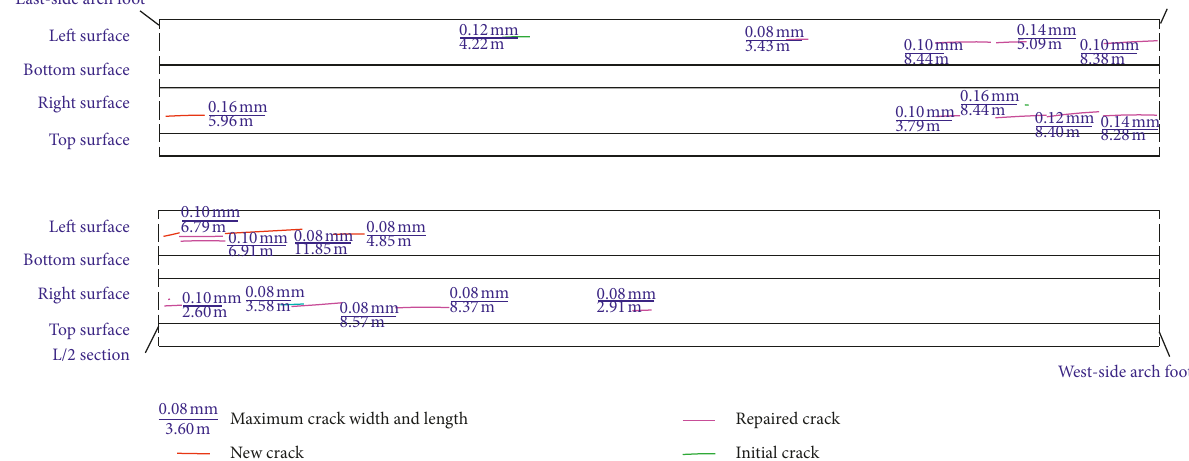
Figure 3: Crack distribution inside #1 arch rib. Note that the crack length and width are not marked when the length is less than 1m.